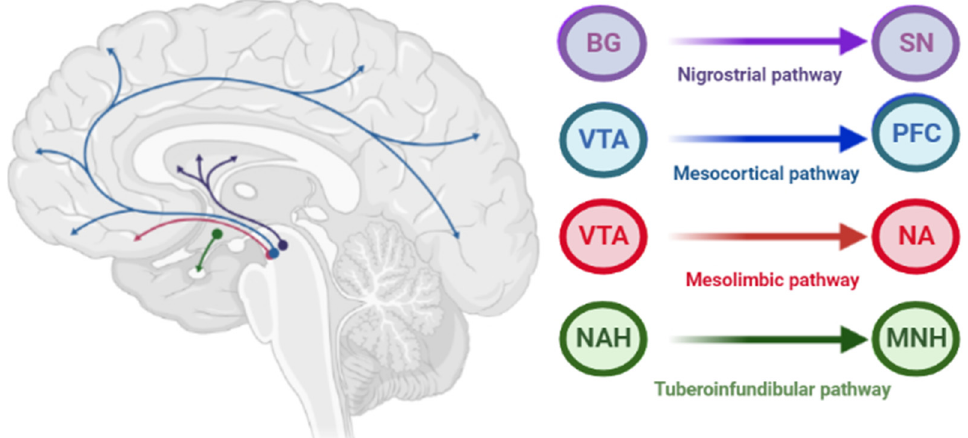
Figure 2. Pathways of dopaminergic neurotransmission. Note : VTA—ventral tegmental area; PFC— prefrontal cortex; NA—nucleus accumbens: SN—substance nigra; BG—basal ganglia (striatum); NAH—nucleus arcuatus (hypothalamus); MNH—middle nucleus (hypothalamus).